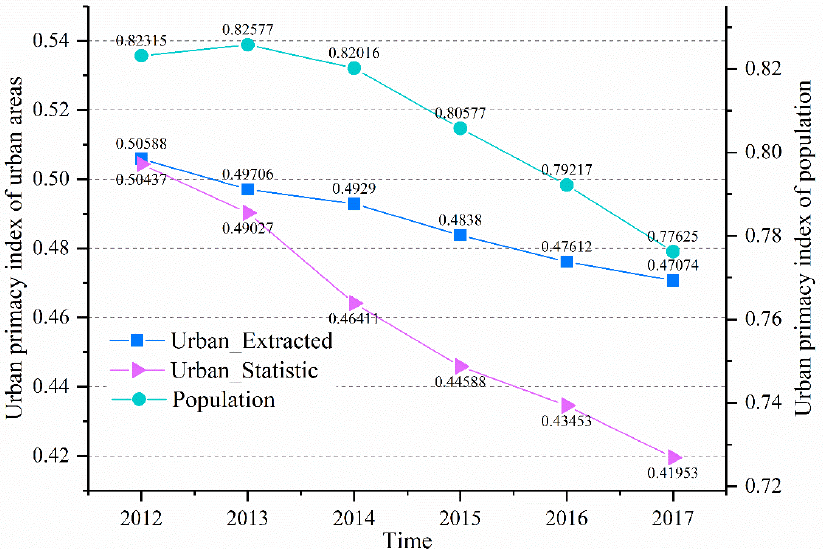
Figure 12. Variations in the urban primacy index for extracted urban areas, statistic urban areas, and population data of the YRD from 2012 to 2017.